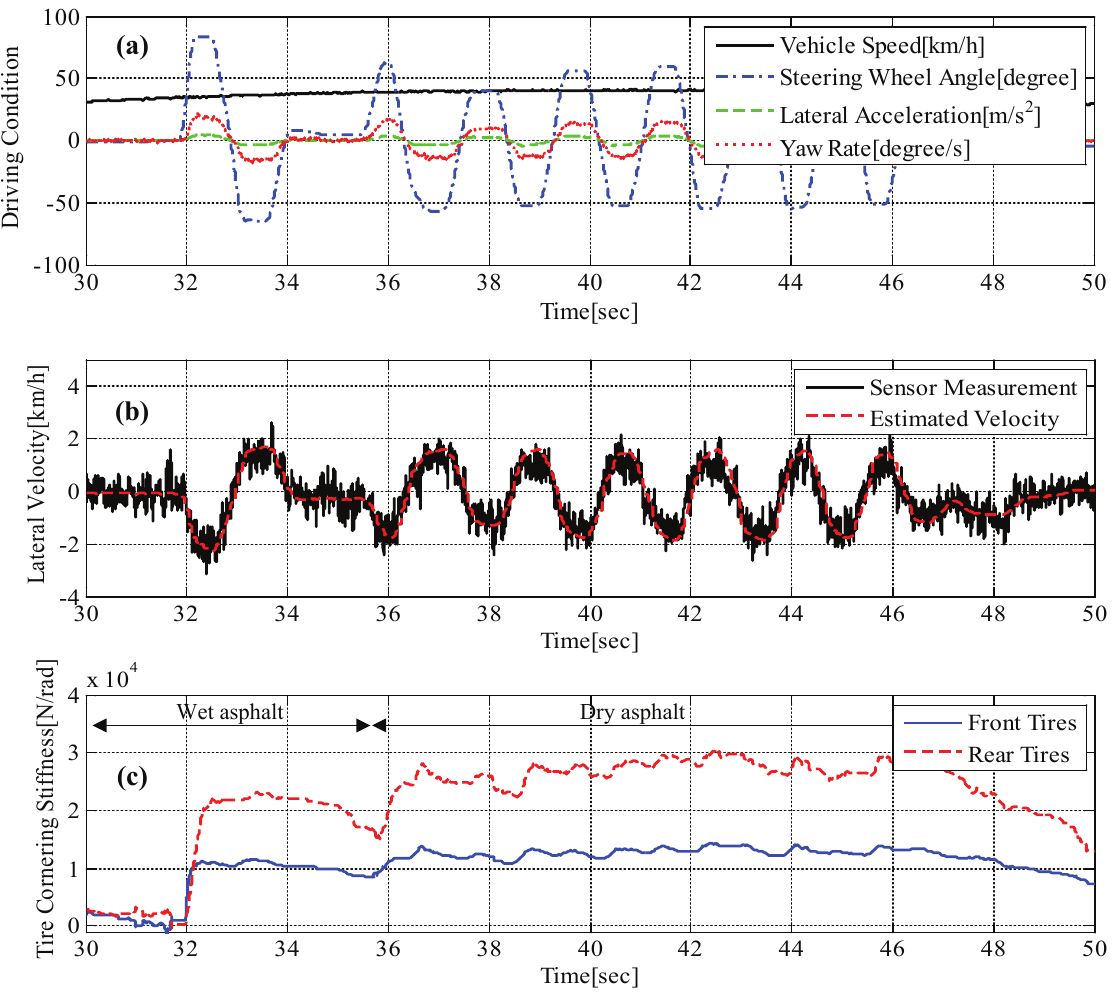
Figure 11. Test result on a high- µ road: ( a ) maneuvering conditions, e.g., vehicle speed, steering angle, measured lateral acceleration and measured yaw rate; ( b ) measured lateral vehicle velocity and estimated lateral vehicle velocity; ( c ) estimated tire cornering